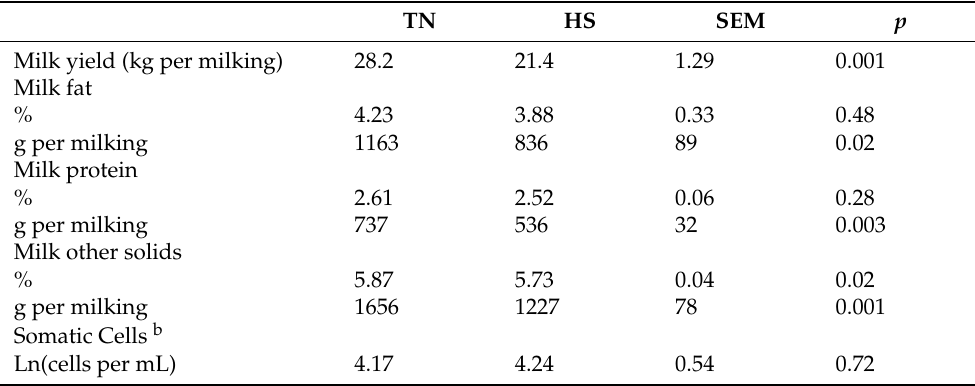
Table 2. Milk yield and components of lactating dairy cows (n = 10) in thermoneutral (TN) or heat stress (HS) conditions for 5 days a